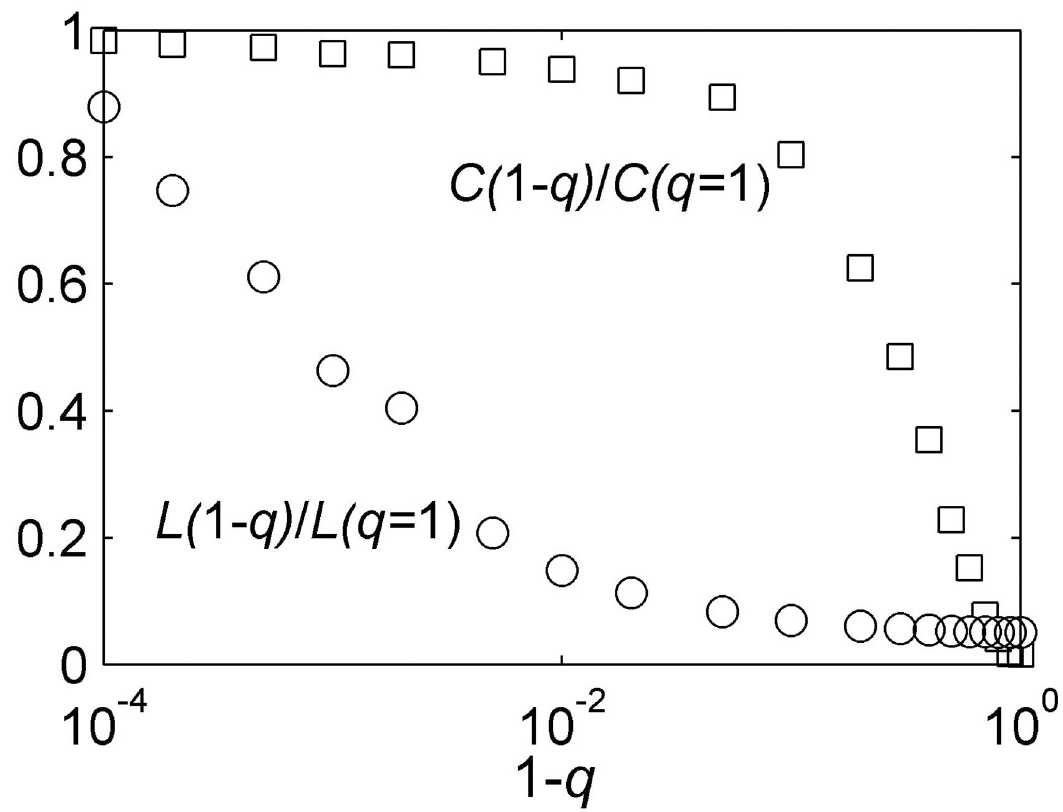
Q is greater than 1, the network has the small world characteristics. However, larger the quotient Q , more significant are the small world characteristics of the network. This means that, as long as q satisfies the condition: 0.0001 < q < 1, the network has a small world